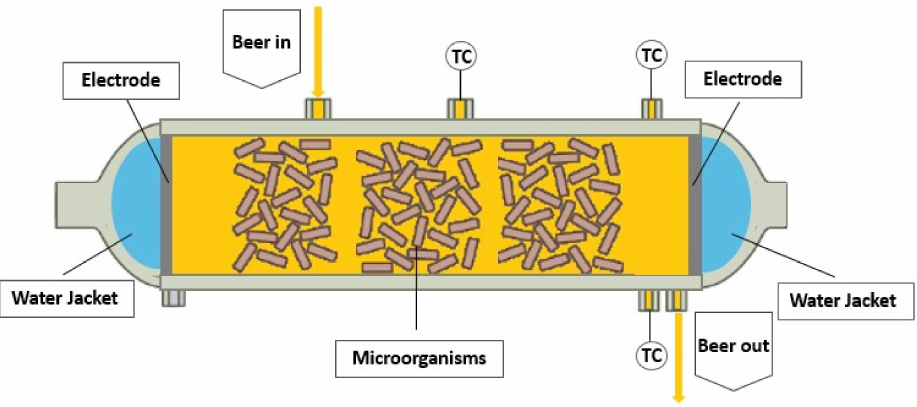
Figure 2. Schematic diagram of a continuous PEF unit for pasteurization with cooling system. The thermocouples are referred to as TC on the